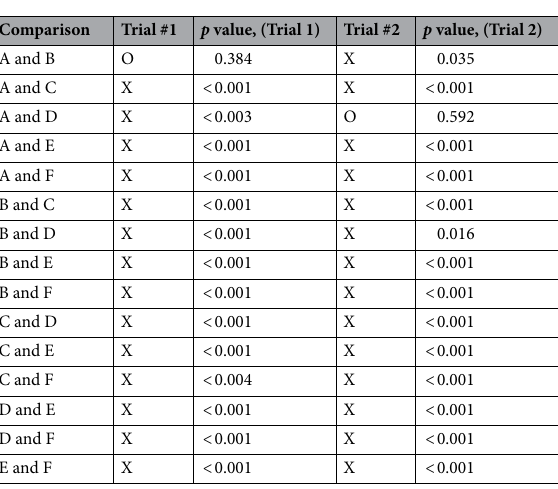
Table 4. ANOVA comparisons between NCIT models for the difference between the reference and the NCIT. “O” stands for not being statistically different between two NCIT models, while “X” stands for being statistically different.